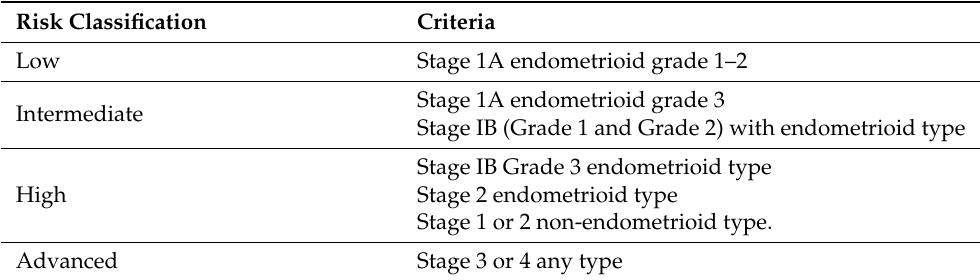
Table 2. Endometrial cancer patient risk group